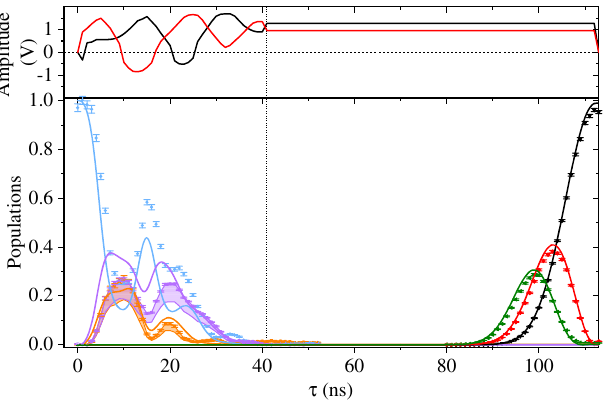
FIG. 5. Circular state preparation with an optimized pulse. The voltage V r and V i for the optimized pulse are shown in the upper panel. The main frame shows the evolution of the population P τ Þ of the levels j as a function of the duration τ , after which the j ð rf pulse is interrupted, for j ¼ m 1 ; m 2 ; m 3 ( τ ≤ 52 ns) and j ¼ e ; e ; c ( τ ≥ 80 ns). The points are experimental with statistical 2 1 error bars, using the color code of Fig. 1. The shaded area (purple and orange) shows the error range for levels m 1 and m 3 due to the uncertainty on the MW probe pulses calibration. The solid lines correspond to the numerical simulation of the experiment. The discrepancy between the data and the simulation at the beginning of the optimized pulse is probably due to the finite bandwidth of the rf circuit. When we set V r and V i to zero at time τ , the rf has a finite ring-down time, which affects the measured population. The effect ofthisringdownisnotvisibleattheendofthepulse,asit corresponds there to a small additional rotation of the spin, which is automatically compensated by the optimization procedure. Finally, we find P c ¼ 96 . 2 ð 3 Þ % , P e ¼ 0 . 20 ð 1 Þ % , P e ¼ 0 . 74 ð 4 Þ % . We 1 2 alsomeasure P e ¼ 0 . 15 ð 7 Þ % , P e ¼ 0 . 13 ð 8 Þ % , P m ¼ 0 . 08 ð 3 Þ % , 3 4 3